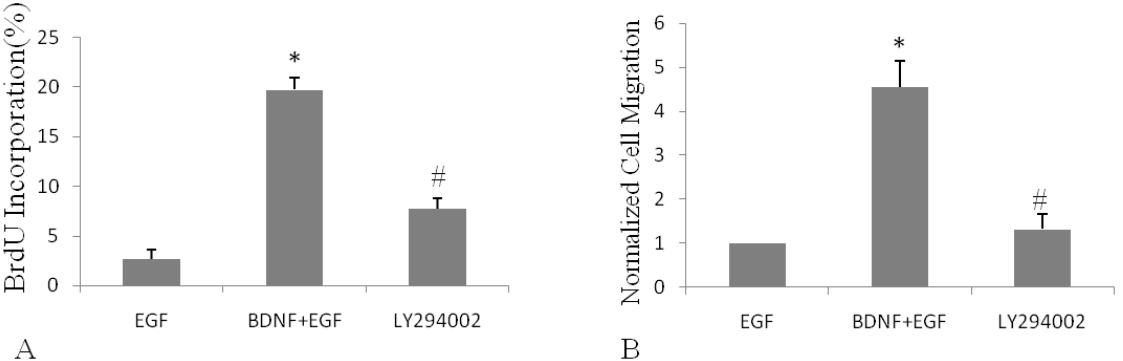
Figure 3. Effects of BDNF on EGF-mediated human NSPC proliferation and migration were abolished by pretreatment with LY294002. EGF: Cells incubated with 20 ng/mL EGF. EGF+BDNF: cells incubated with 20 ng/mL EGF and 50 ng/mL BDNF. LY294002: Cells incubated with LY294002 before exposure to 20 ng/mL EGF and 50 ng/mL BDNF. * p < 0.05, as compared with the EGF group; # p < 0.05, as compared with the BDNF+EGF